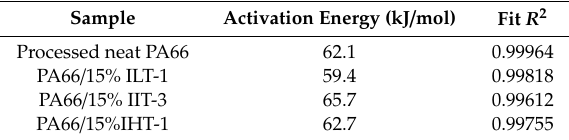
Table 2. Fit parameters of the Arrhenius equation.